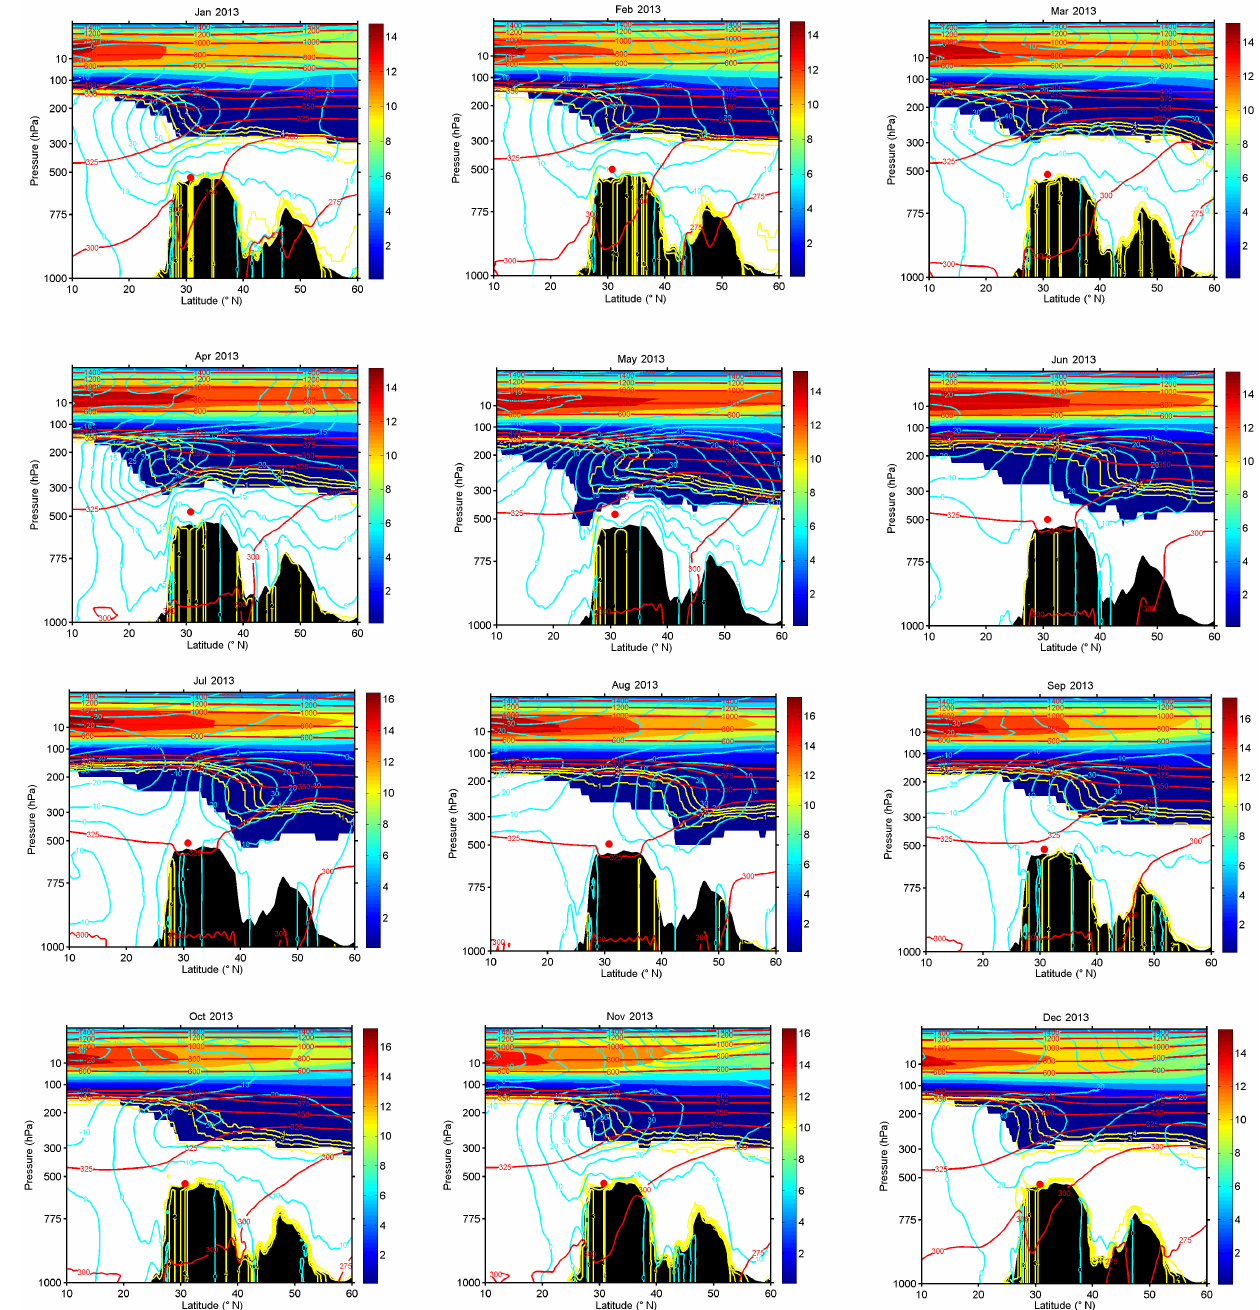
Figure 5. Monthly mean meridional cross section at 91 ◦ E (over Nam Co Station) at 20:00UTC + 8 in 2013, derived from ERA-Interim data, including zonal winds (cyan contours; ms − 2 ), potential vorticity (yellow lines, contours of 1, 2, 3 and 4 potential vorticity units), ozone (solid color; × 10 6 kgkg − 1 ) and potential temperature (red contours; K). The color bar shows the scale for the contour plots of ozone concentration. The area in black shows the cross section of the Tibetan Plateau terrain. The red dots show the position of the top of the PBL (planetary boundary layer) at Nam Co